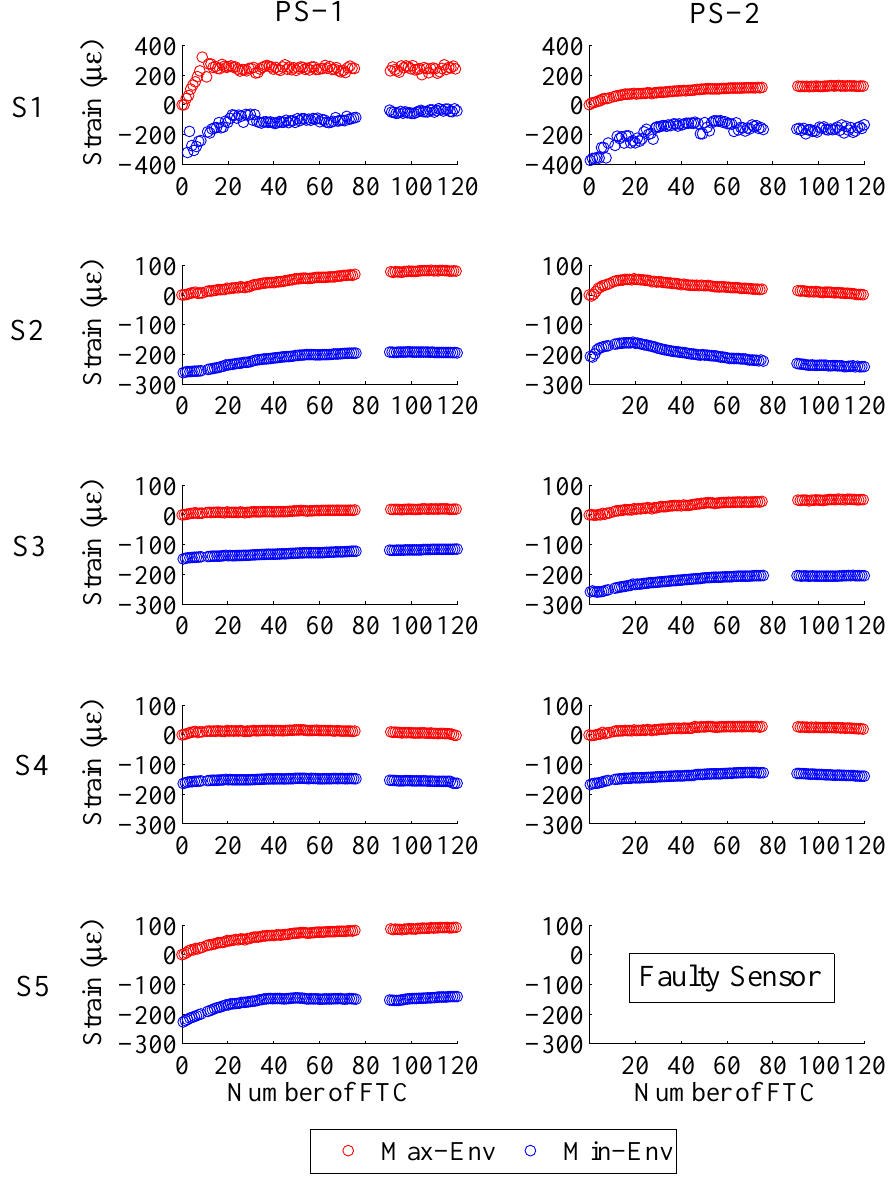
Figure A1. Maximum and minimum strain envelopes of prestressed blocks measured during freeze-thaw cycles. The gap around Cycle 80 is due to the interruption of the data acquisition. Sensor Positions S1–S5 are provided in Figure